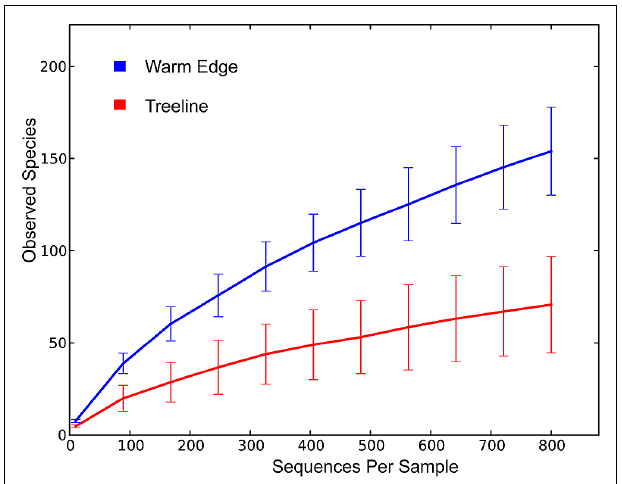
FIGURE 1 | Rarefaction curves forWE and treeline samples. There is no apparent asymptote in the rarefaction curves, suggesting that the sequencing depth does not encompass the full extent of phylotype richness in each of the communities. However, the rarefaction curves suggest that the lower number of phylotypes recovered from treeline samples was not due to insufficient sampling.The high and low of the error bars represent one SD away from the